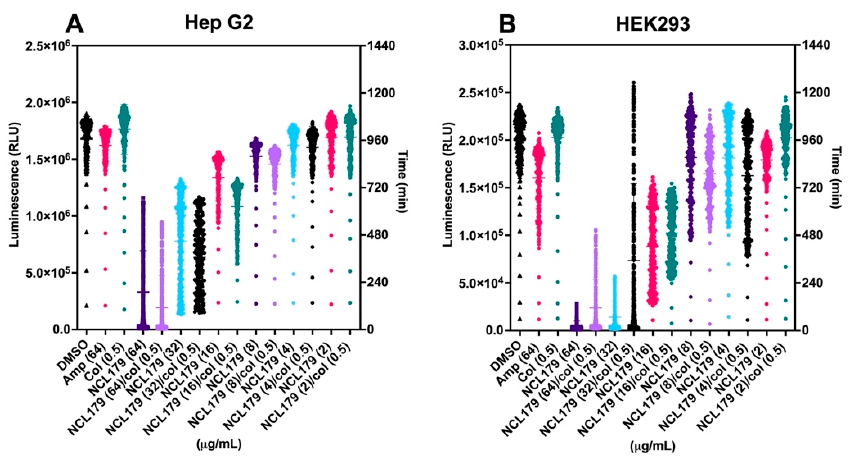
Figure 4. In vitro toxicity assessment of NCL179 alone and in combination with colistin. Real-time cell viability measurement for Hep G2 ( A ) and HEK293 ( B ) cells after treatment with different con- centrations of NCL179 alone and in combination with 0.5 µg/mL of colistin. The cell viability was determined using the RealTime-Glo TM MT Cell Viability Assay reagent (Promega, , Madison, WI, USA) and measured every hour for 20 h at 37 °C in 5% CO 2 on a Cytation 5 Cell Imaging Multi- Mode Reader (BioTek, BioTek, Winooski, VT, USA). Data are relative light units (RLU) for each treatment per time point; col, colistin; Amp, ampicillin.